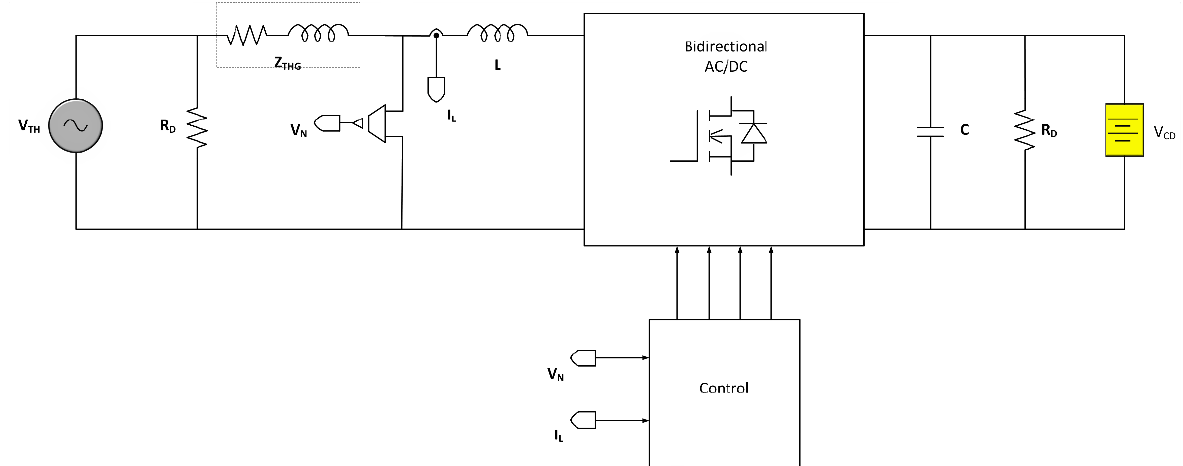
Figure 9. Connecting the system to the node. The prototype specifications are illustrated in Table